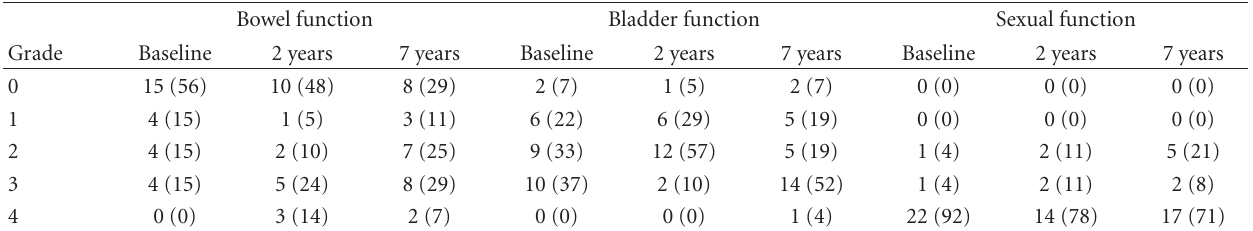
Table 2: Late e ff ects in normal tissues subjective, objective, management and analytic scales (LENT/SOMA) data: number of patients with maximum scores per symptom area (percentage of patients in